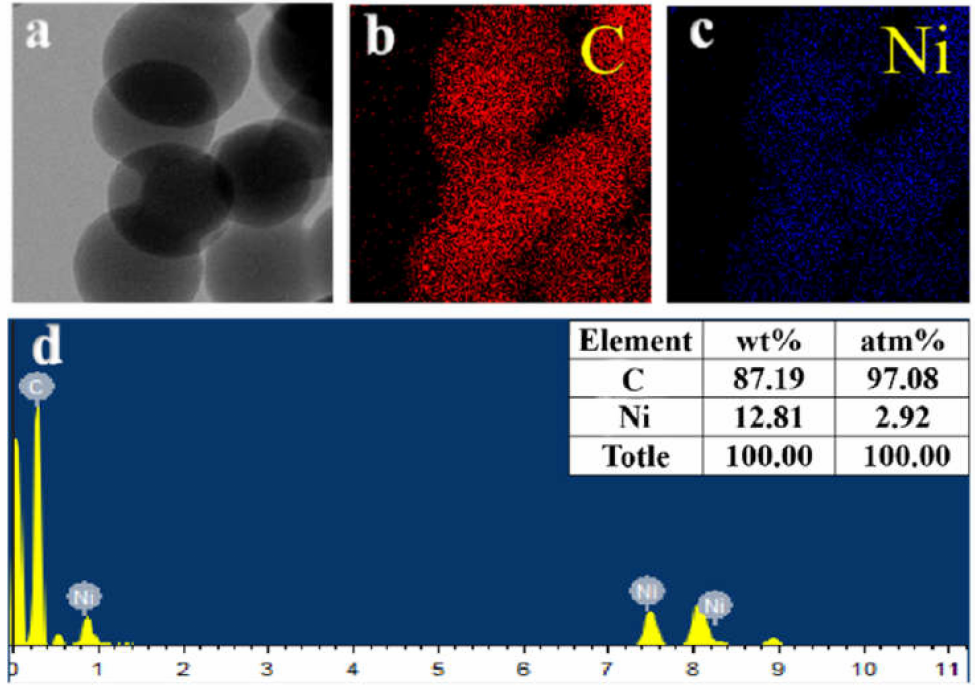
Figure 2. [M7] HRTEM image ( a ), the corresponding element mapping of C ( b ) and Ni ( c ) elements, EDS pattern ( d ) and elemental contents (inset) of carbon-supported metal